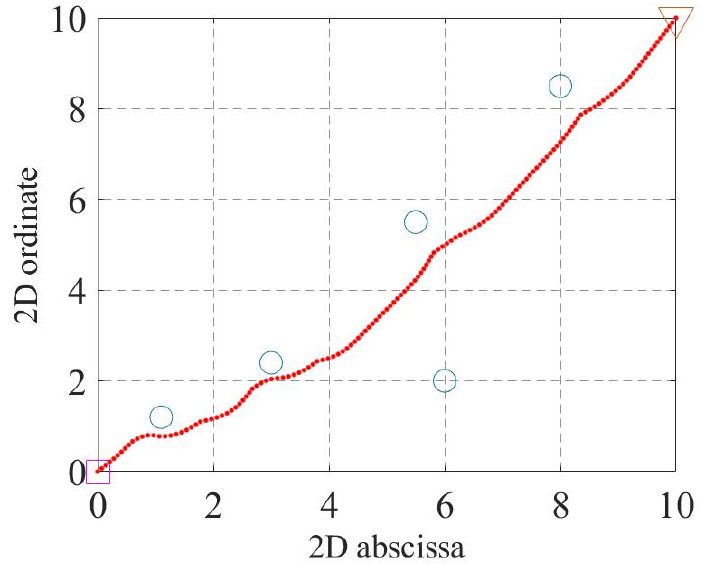
Figure 10. Simulation results of improved artificial potential field method.